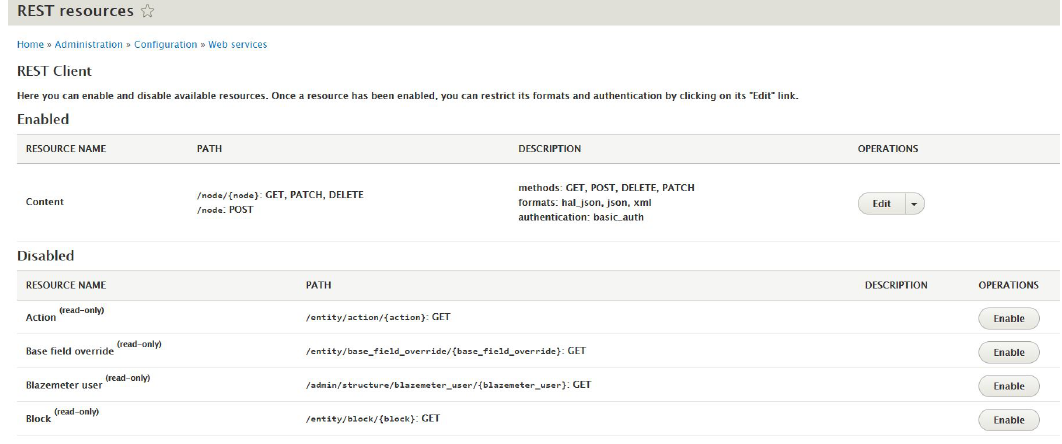
Figure 13. Rest client module configuration.